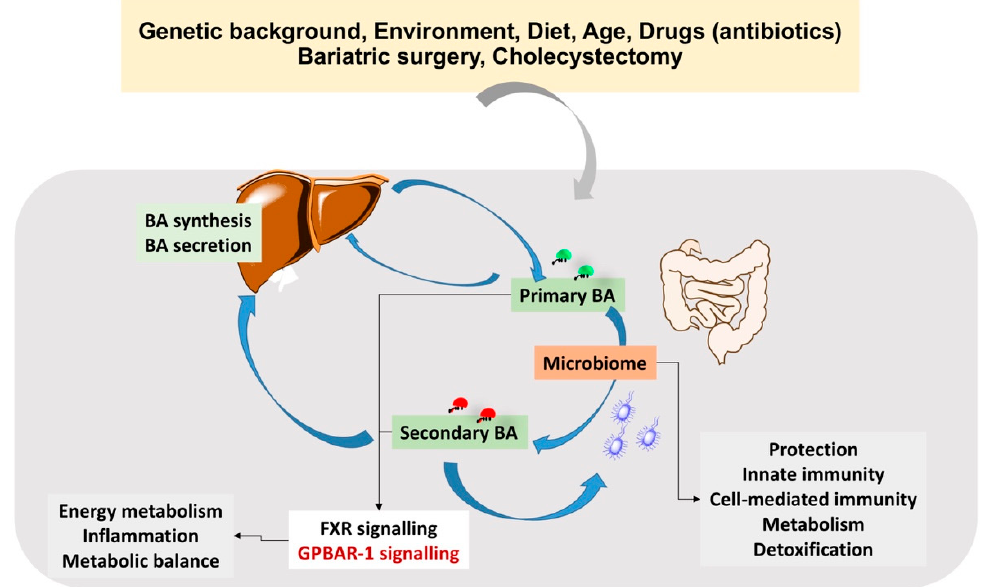
Figure 8. Mutual interaction between BA and gut microbiome. BA undergo biotransformation by the microbiome, a step contributing to the final composition of the BA pool. BA play an important role as signalling molecules (FXR and GPBAR-1), contributing to several metabolic functions and with a role in immunological and inflammatory aspects. BA also control gut bacteria growth.